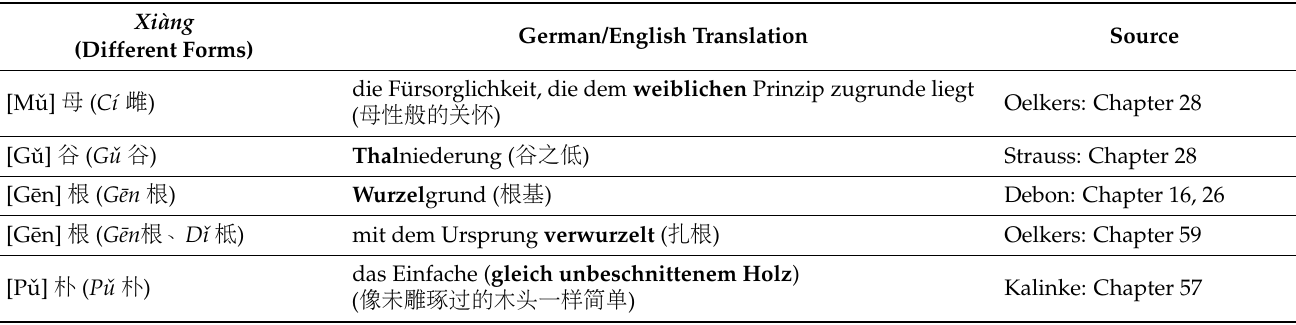
Table 8. The Partial Concealment of Xi à ng in the German Translation of the D à o D é J¯ıng . Xi à ng German/English (Different Forms)